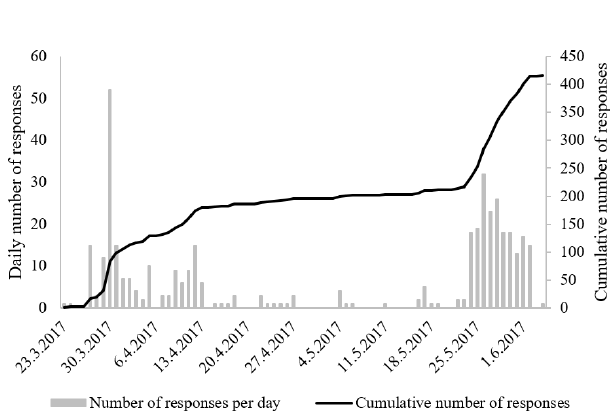
Figure 2. The rate of responses received on CLIPS online survey during the 10 weeks open period.